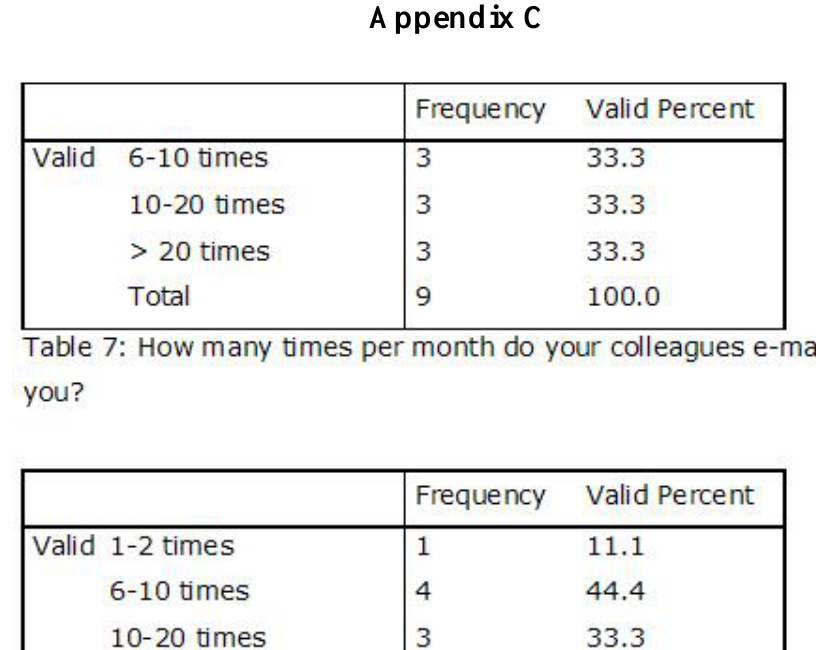
Fouche ~ A Multi-Island Situation Without the Ocean: Tutors’ perceptions about working in isolation from